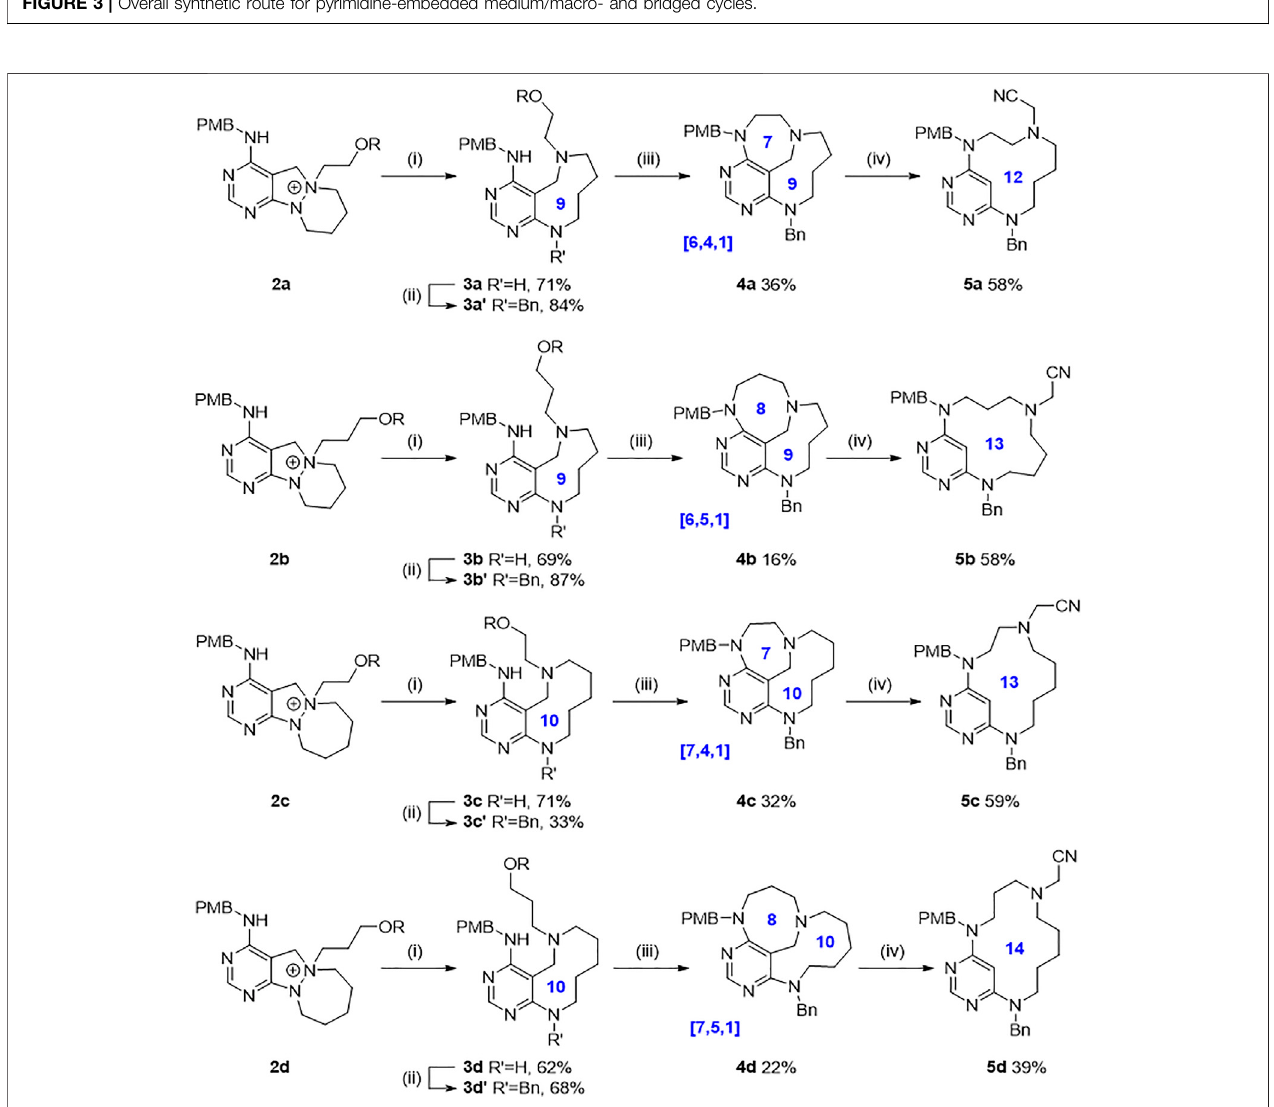
SCHEME 1 | Exploration for each scaffold. Reagents and conditions: (i) NaOEt, NaBH 4 , EtOH, 60 ° C; (ii) BnBr, ACN, r.t.; (iii) HF/pyridine/THF, r.t., then MsCl, TEA, DCM, r.t., then NaH, dry DMF, r.t.; (iv) AuCl, TMSCN, DCE, 80 C. R = tert -butyldiphenylsilyl.